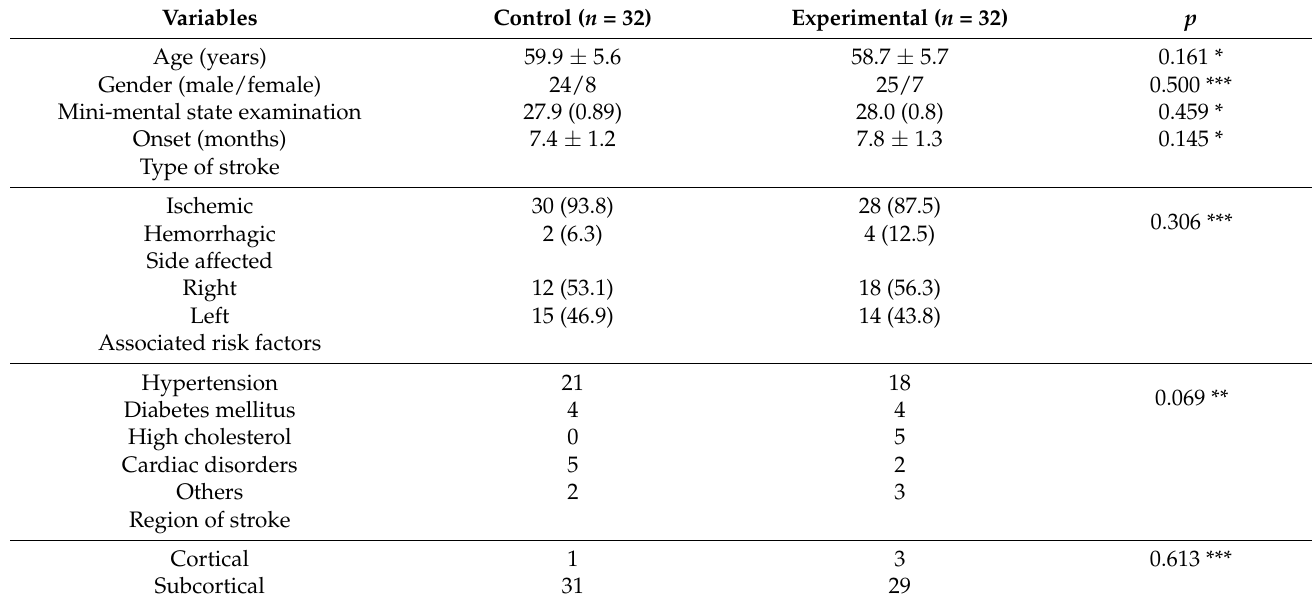
Table 2. Demographic characteristics of participants.